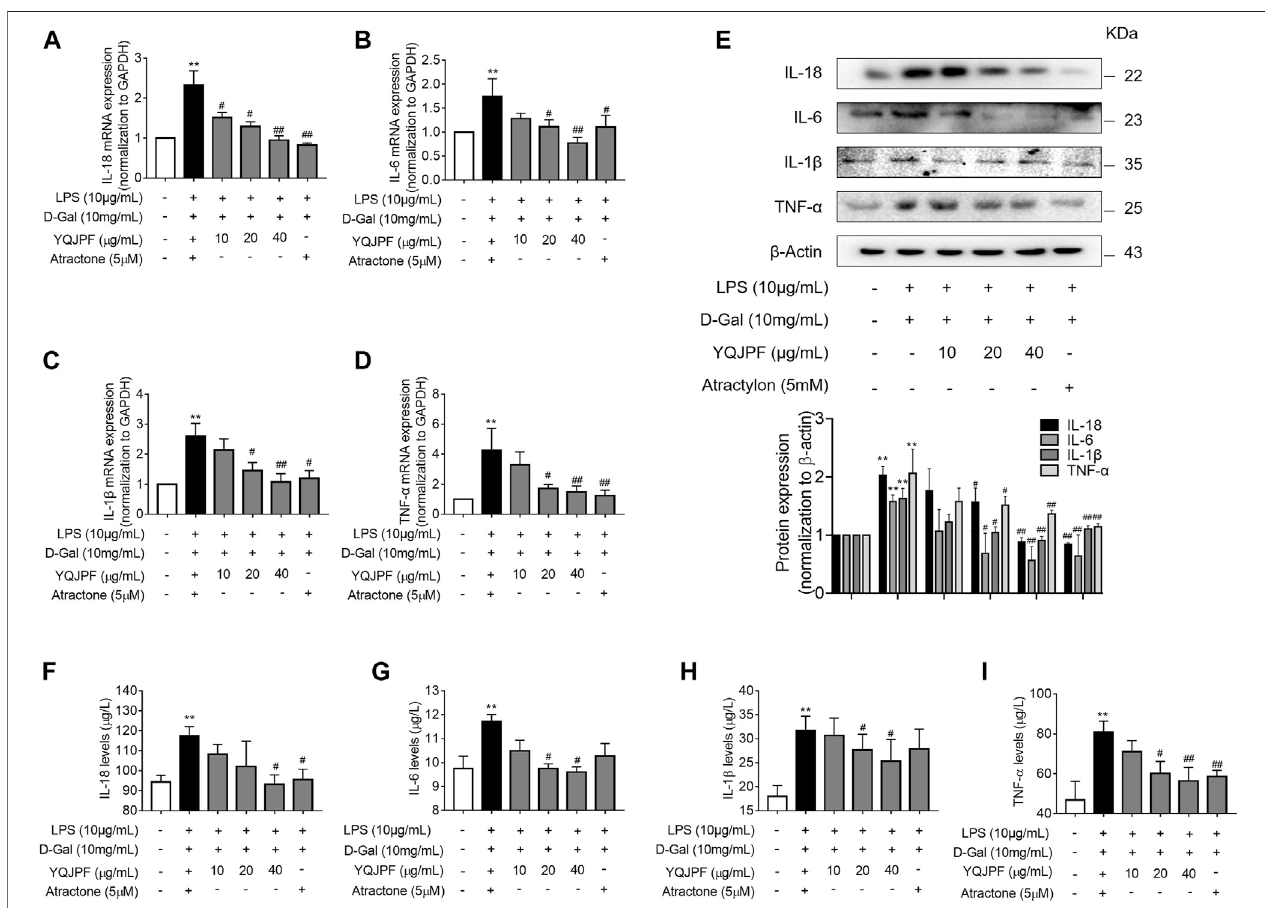
FIGURE 6 | YQJPF inhibited necroptosis of LPS- and D-Gal-treated hepatocytes in vitro . Human LO2 cells were treated with LPS + D-Gal for 4 h and further with YQJPF and atractylone. (A – D) Real-time PCR analyses of genes of pro-in fl ammatory cytokines IL-1 β , IL-6, TNF- α , and IL-18. (E) Western blot analysis and quantitative analysis of the expression of pro-in fl ammatory cytokines IL-1 β , IL-6, TNF- α , and IL-18 (F – I) Expression levels of IL-1 β , IL-6, TNF- α , and IL-18 in LO2 were detected by ELISA. Data are expressed as mean ± SD ( n (cid:2) 3). *vs. control group, # vs. LPS + D-Gal group; * p < 0.05, ** p < 0.01; # p < 0.05, ## p < 0.01.